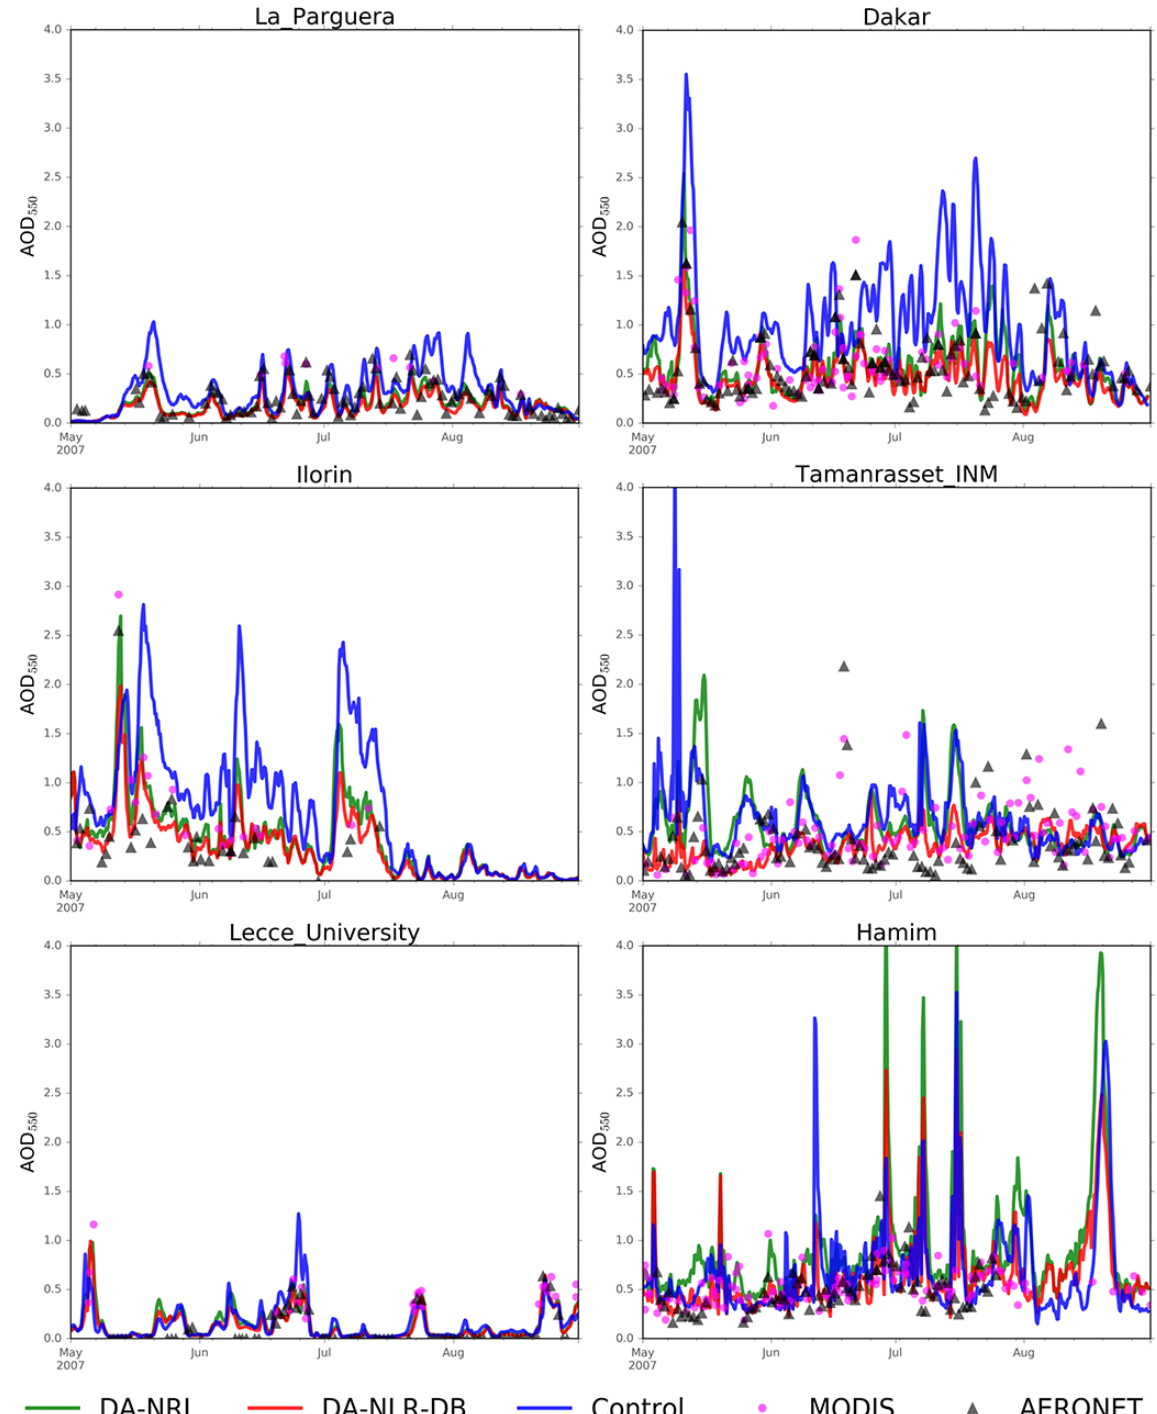
Figure 11. Time series of AOD values for May and August 2007 in La Parguera (top left), Dakar (top right), Ilorin (centre left), Tamanrasset INM (centre right), Lecce University (bottom left), and Hamim (bottom right) for the Control (blue), DA-NRL (green), and DA-NRL- DB (red) experiments, for MODIS AOD (NRL and DB; magenta circles), and for AERONET AOD (black triangles) in dust-dominated conditions. Analysis values are used for the data assimilation